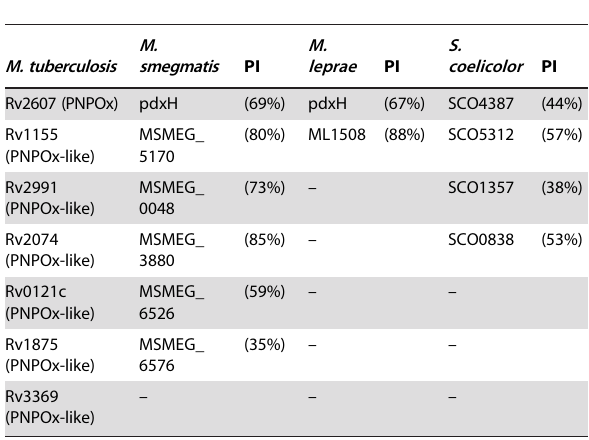
Table 1. Summary of NCBI gene annotations for PNPOx-like proteins in selected organisms that contain pdx1 and pdx2 and the role of PNPOx is considered to be for PLP